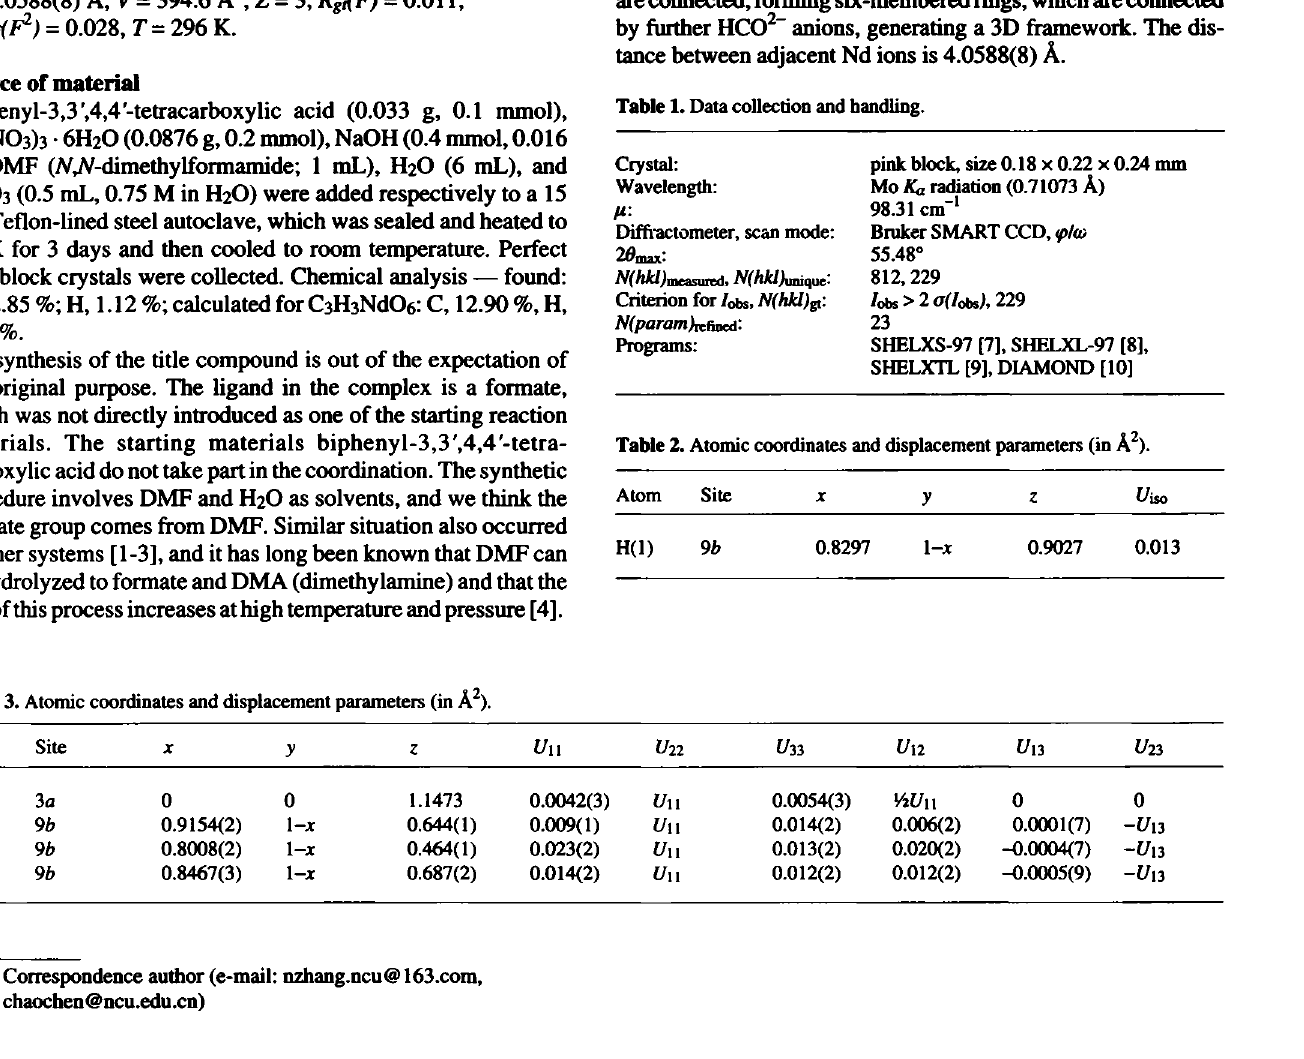
Table 3. Atomic coordinates and displacement parameters (in Â 2